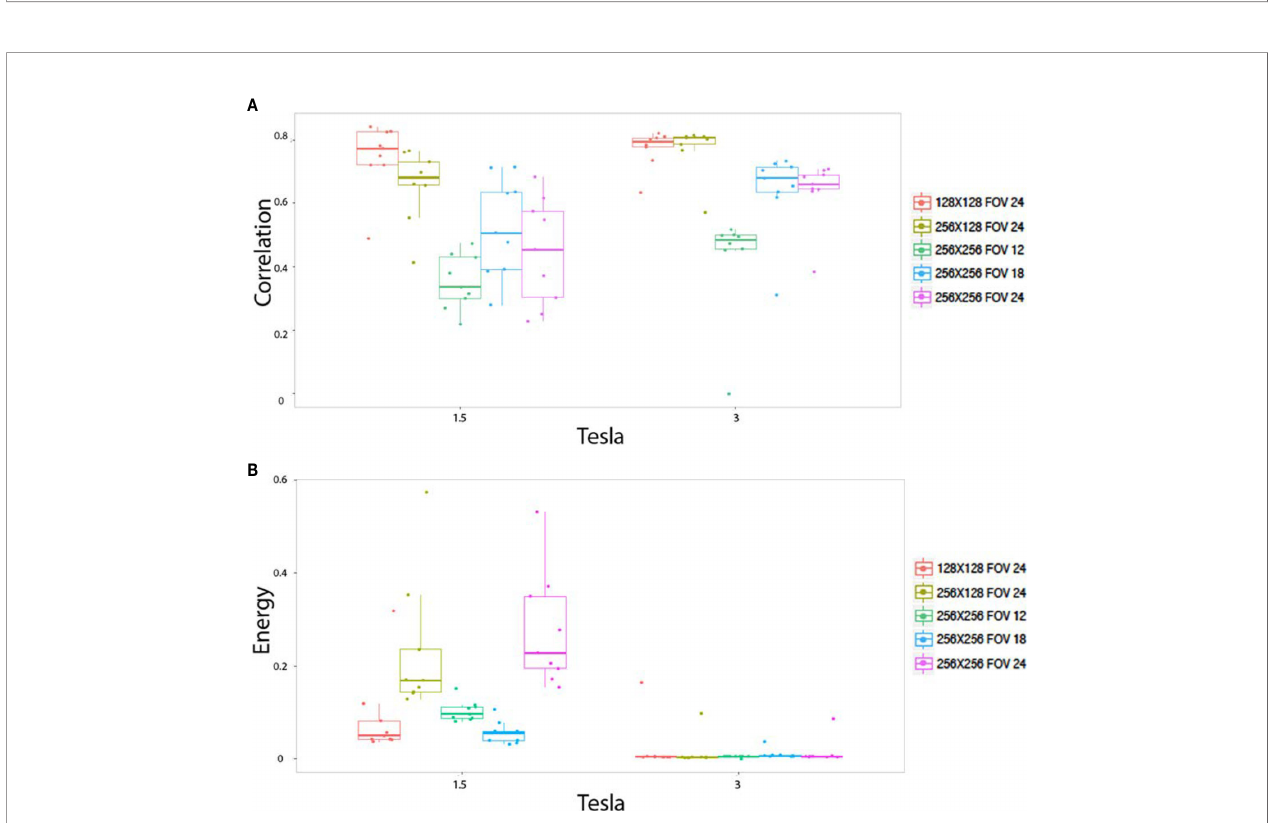
FIGURE 4 | In vitro parameters value according to magnetic fi eld strengh and pixel size: For correlation (A) and energy (B) . Texture features extracted to the homogeneous phantoms. Each colored dot groups and related box plot shows the value of correlation (A) and energy (B) calculated from repeated phantom MRI acquisition (one dot per MRI acquisition) with different pixel size (one color per matrix/FOV couple), respectively, at 1.5 and dissimilarity, LZHGE, entropy, homogeneity, SRE, SZE, LRE, identi fi ed the (visually obvious) difference between homogeneous GLNU, RLNU, ZLNU, KurtosisH, LZE, entropyH, coarseness, and heterogeneous phantoms, with an absolute Spearman ’ s rho SRLGE, SRLGE, SZLGE, and LGRE. Two texture features correlation coef fi cient above 0.5. The following texture features (coarseness, RLNU) identi fi ed the difference between identi fi ed the difference between the different heterogeous homogeneous tubes (mainly different by their Gadolinium chelate phantoms (mainly different according to their polystyrene beads concentration). As long as the pixel size remains suf fi ciently tiny size and spatial distribution) in both fi eld sthrengh separatly: